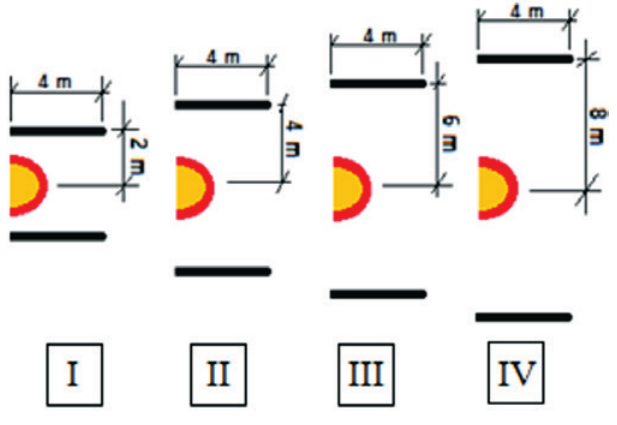
Figure 3 I) Obstacles at 2 m from explosion; II) Obstacles at 4 m from explosion; III) Obstacles at 6 m from explosion; IV) Obstacles at 8 m from explosion